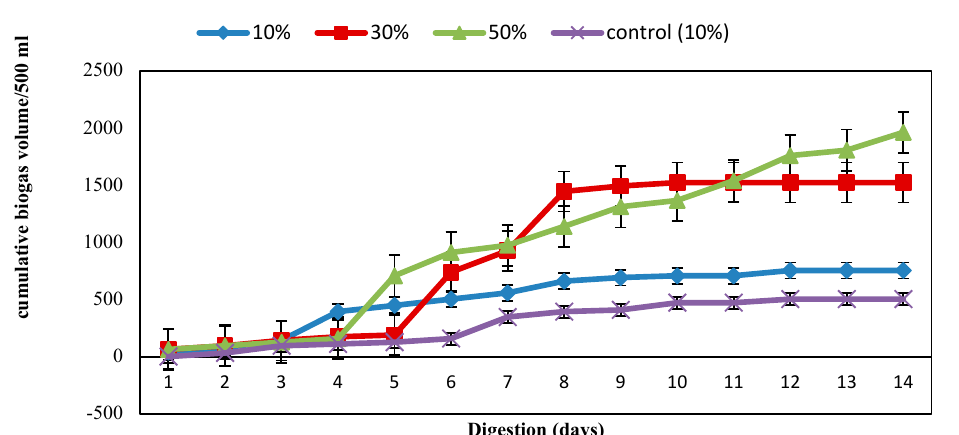
Figure 8. Cumulative biogas produced in each digester at HRT= 25 days, T = 37 °C. Digester volume of 500 mL and digestion time of 14 days.